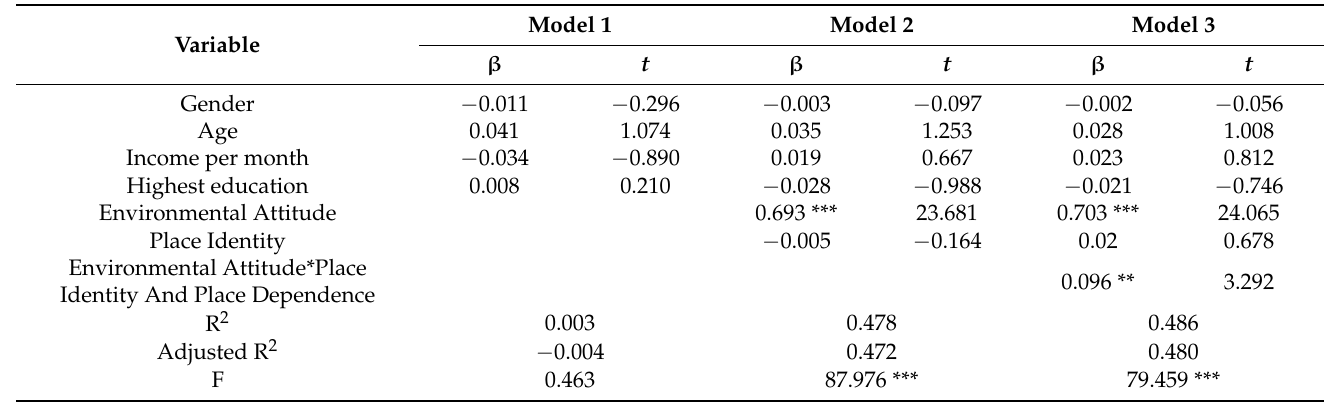
Table 13. Moderating effect test of place identity and place dependence influence on the interaction between environmental attitude and pro-environmental behavior.